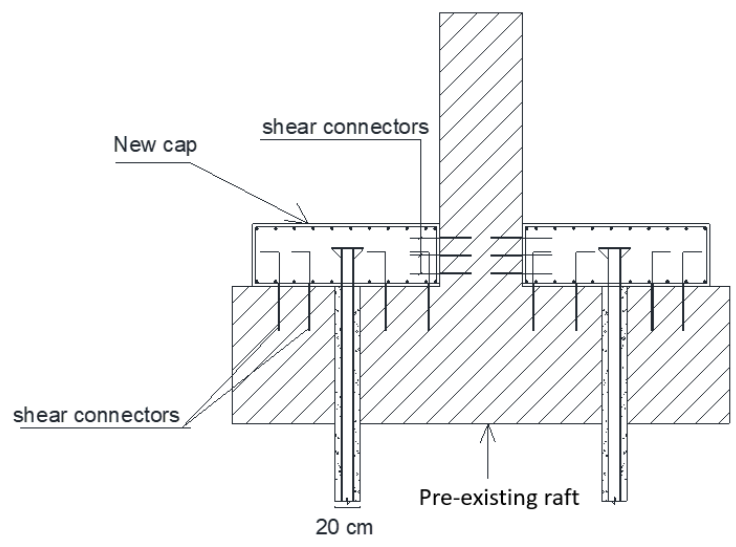
Figure 9. Sample cross-section of the micropiled raft.